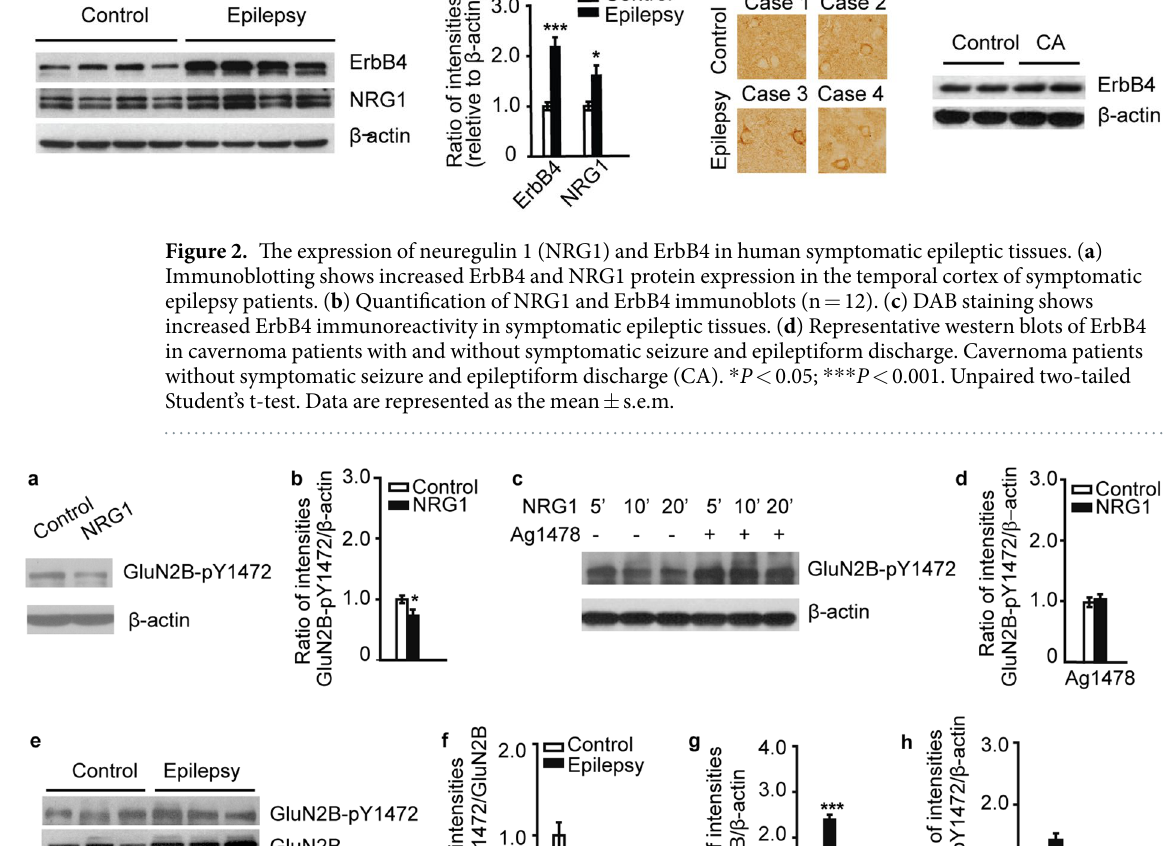
phosphorylation in human tissues, human brain slices from control subjects were incubated with NRG1 and the level of GluN2B phosphorylation measured. The results showed that NRG1 incubation resulted in a suppression of GluN2B-pY1472 (Fig. 3a and b). To determine whether GluN2B-pY1472 suppression by NRG1 was dependent on ErbB4, fresh brain slices were preincubated with an ErbB4 inhibitor, Ag1478, before NRG1 incubation. The results showed that Ag1478 markedly attenuated GluN2B-pY1472 suppression induced by NRG1 (Fig. 3c and d). This result confirmed that the phosphorylation of GluN2B at Y1472 is subject to regulation by NRG1-ErbB4 signaling. To test whether the phosphorylation level of GluN2B at Y1472 is altered in human symptomatic epileptic tissues, we used temporal cortical tissues from symptomatic epilepsy CA patients and measured the levels of GluN2B and phosphorylated GluN2B. The phosphorylation level of GluN2B at Y1472 was significantly decreased in symptomatic epileptic tissues compared with that of the controls (Fig. 3e and f). Though the protein level of GluN2B was significantly increased in tissues from symptomatic epilepsy patients (Fig. 3e and g), the expression of GluN2B-pY1472 protein was not significantly different in symptomatic epilepsy tissues compared to control group (Fig. 3e and h). Taken together, these results suggest that GluN2B may function as a molecular target of NRG1-ErbB4 signaling in human symptomatic epileptic brains.